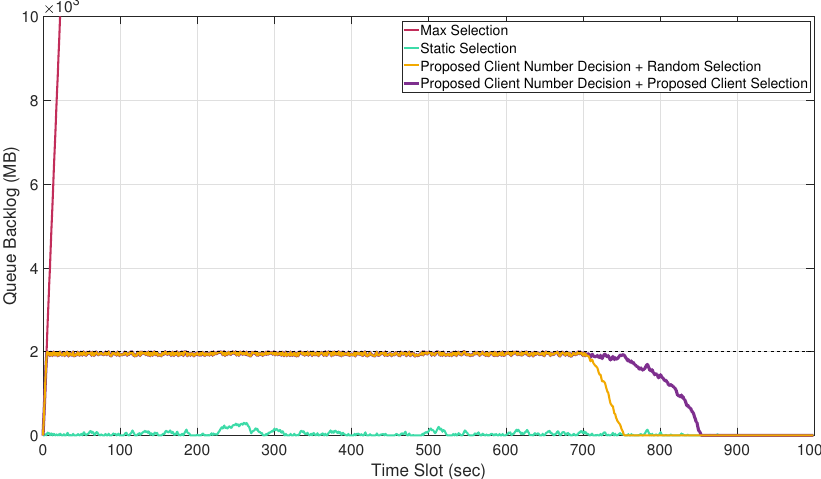
Figure 9. Queue backlog variation plots (y) versus time slot (x). The decided number of clients of the proposed algorithm and random selection is same. However, proposed algorithm selects the clients which to transmit the data by our proposed client selection which considers the resource and random selection just randomly selects the